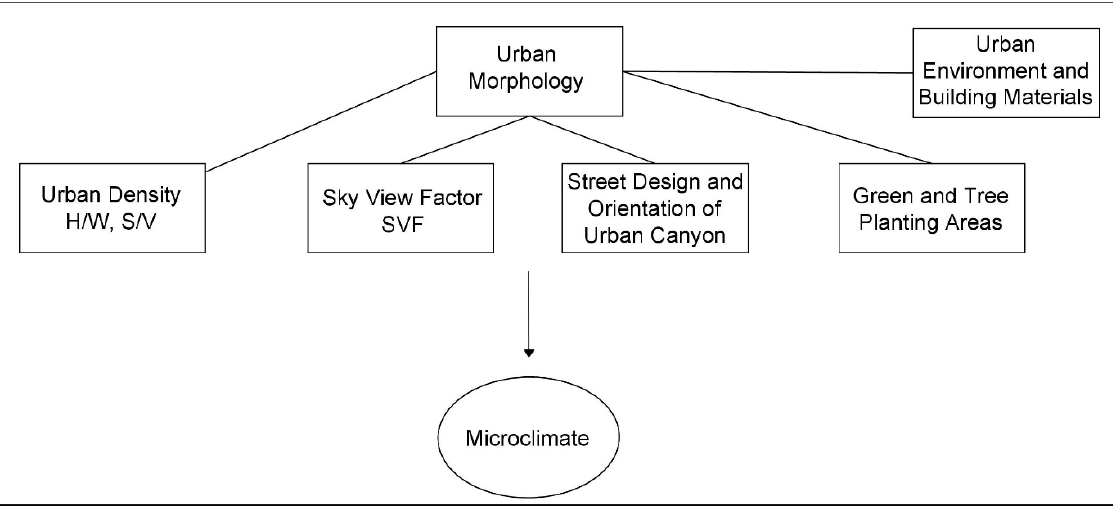
Figure 1. Controlled factors related to urban morphology and influencing the formation of the microclimate.